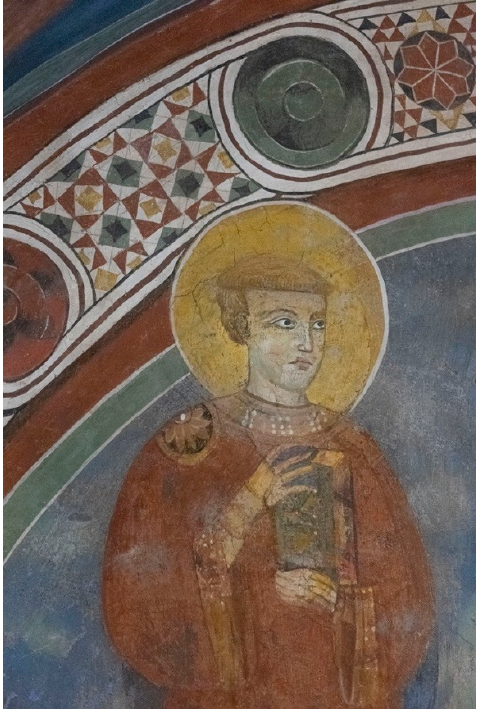
Figure 10. Sacro Speco, Subiaco (Italy), Lower Church. Fresco. Lunette, particular of St. Stephan. Photo: Davide